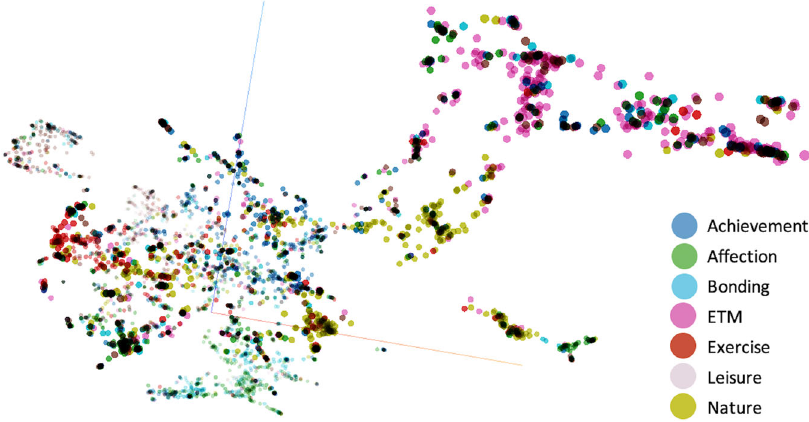
Fig. 3 Keyword embeddings visualization using Tensor fl ow Embeddings Projector. It shows all the keywords and their position in the vector space with a speci fi c color, each representing a